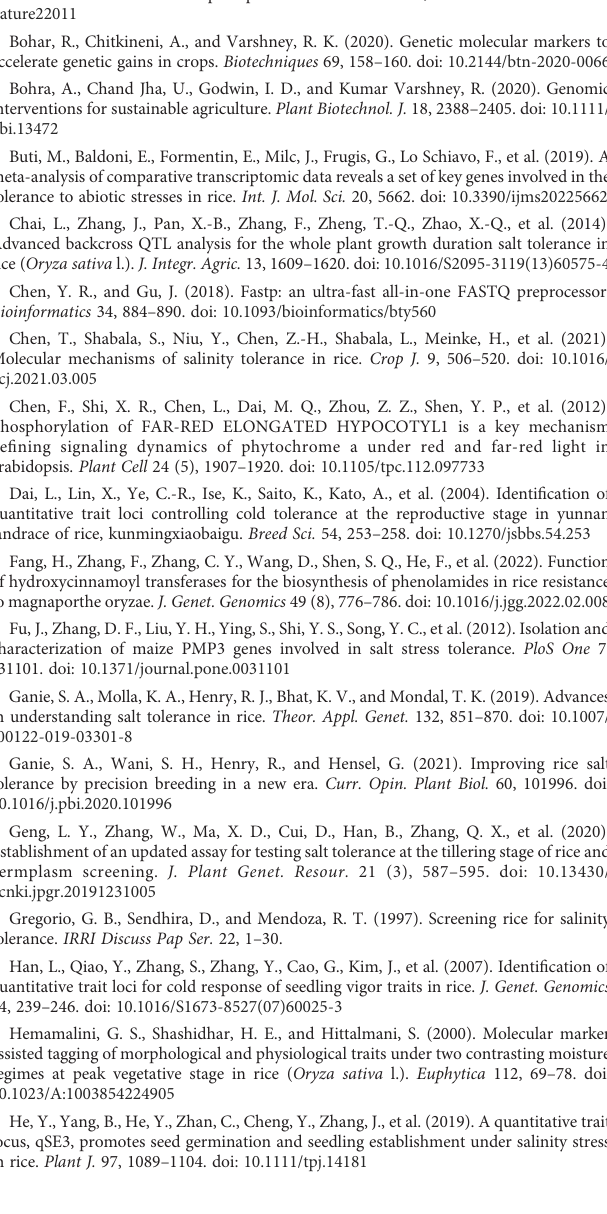
SUPPLEMENTARY TABLE 5 Overview of SNP number SUPPLEMENTARY TABLE 6 Information of Bin marker. SUPPLEMENTARY TABLE 7 Information of genetic map SUPPLEMENTARY TABLE 8 Genes regulated to salt-stress by RNA-seq analysis SUPPLEMENTARY TABLE 9 Primer of candidate genes for qRT-PCR